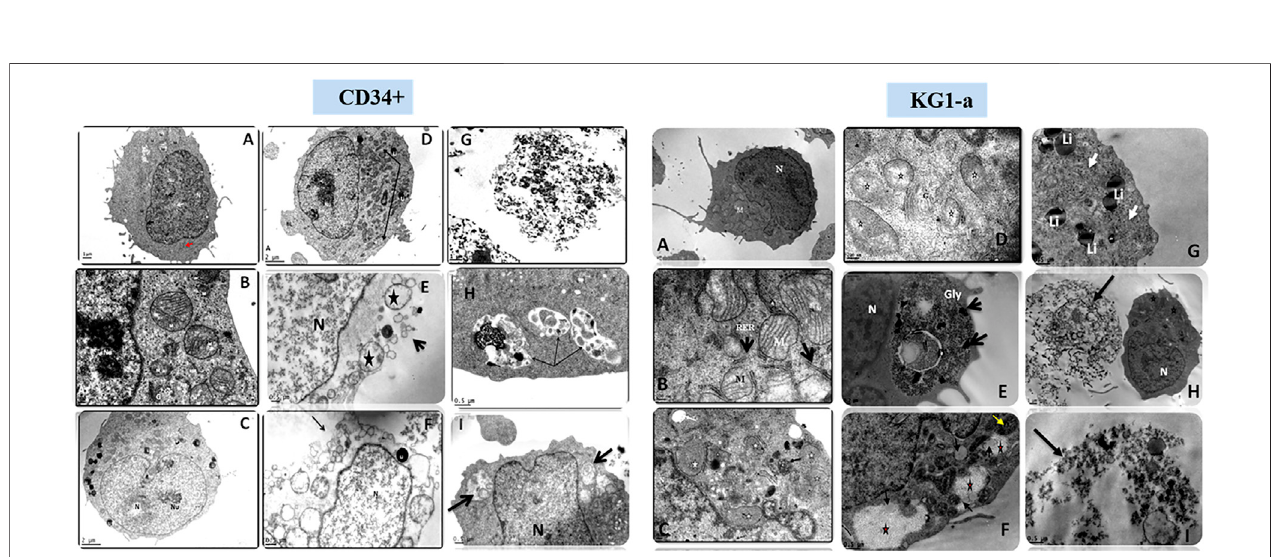
FIGURE 2 | Transmission electron micrograph of CD34 + and KG1-a cells showing the effects of Smp24 and Smp43 treatment on their cell components. CD34 + , (A,B) , control untreated cells showing normal ultrastructure of the cell. (C,D) cells treated with 1/2 LC 50 concentration of Smp43 and Smp24, respectively, showing obviousincreaseincellsize,mitochondriawerewithinconspicuouscristae(star,arrow)andmanylipiddroplets(Li). (E – I) cellstreatedwithLC 50 concentrationofSmp24 and Smp43. Most of cells were completely lysed (G) while other cells (E,F) showed ruptured cell membrane (arrow), karyolysis nucleus (N) and many lucent vacuoles (star). Autolysosomes were also noted (arrow) in the cytoplasm (H,I) . KG1-a, control untreated cells showing normal ultrastructure of the cell. (C,D) , cells treated with 1/2 LC 50 concentration of Smp43 and Smp24, respectively, showing mitochondria were with inconspicuous cristae (star) and appearance of lucent vacuoles(Whitearrow)andmultivesicularbody(blackarrow). (E – I) cellstreatedwithLC 50 concentrationofSmp24andSmp43.Mostofcellswerecompletelylysed (H,I) while other cells (G) showed deposition of lipid droplets (Li), and deposition of glycogen granules (E,F) inside lysosomes (Gly, star) deposits of dense pigments (arrow).